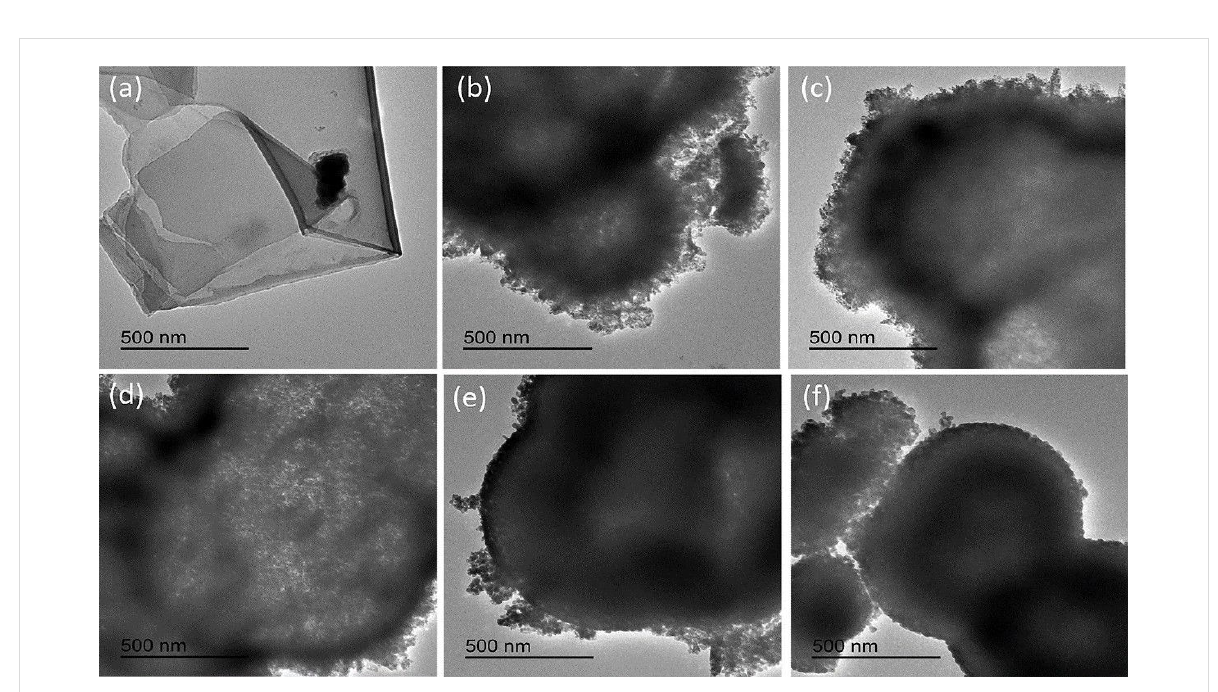
Figure 5: TEM images of (a) GO (b) hollow spheres of ZnFe 2 O 4 and (c–f) hollow spheres of the ZnFe 2 O 4 /rGO composites containing 0.1, 0.25, 0.5, 1 wt % of rGO.